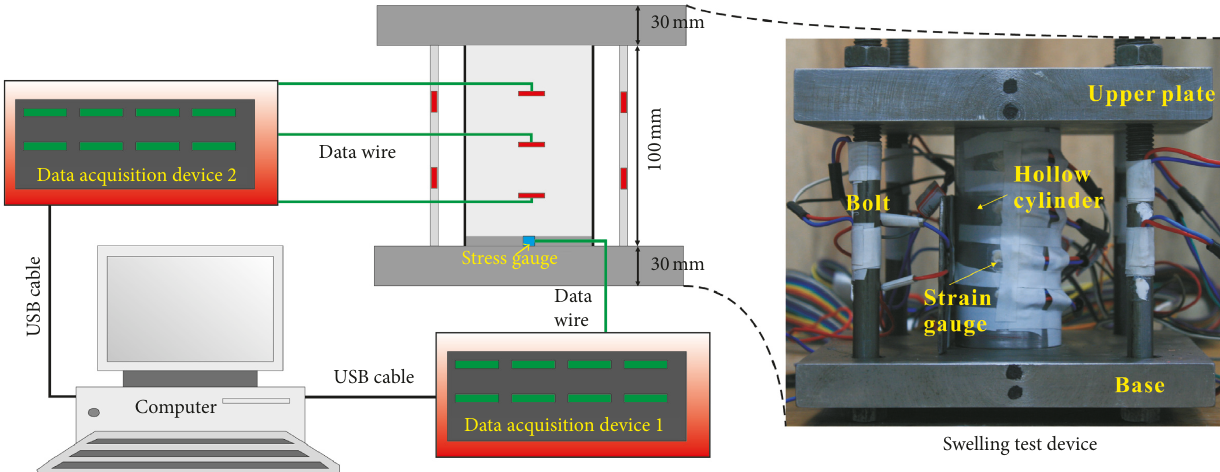
Figure 3: Swelling test device and the connections with the computer and data acquisition